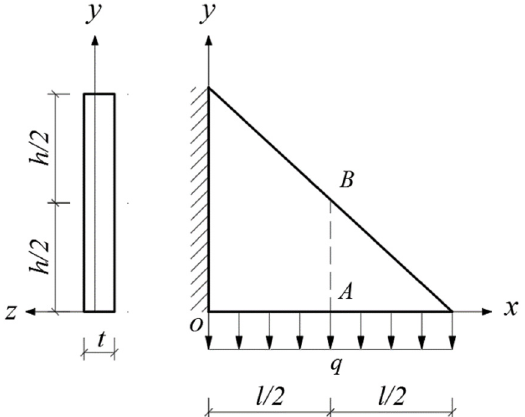
Figure 8. Bimodular triangular plate with bottom loaded.